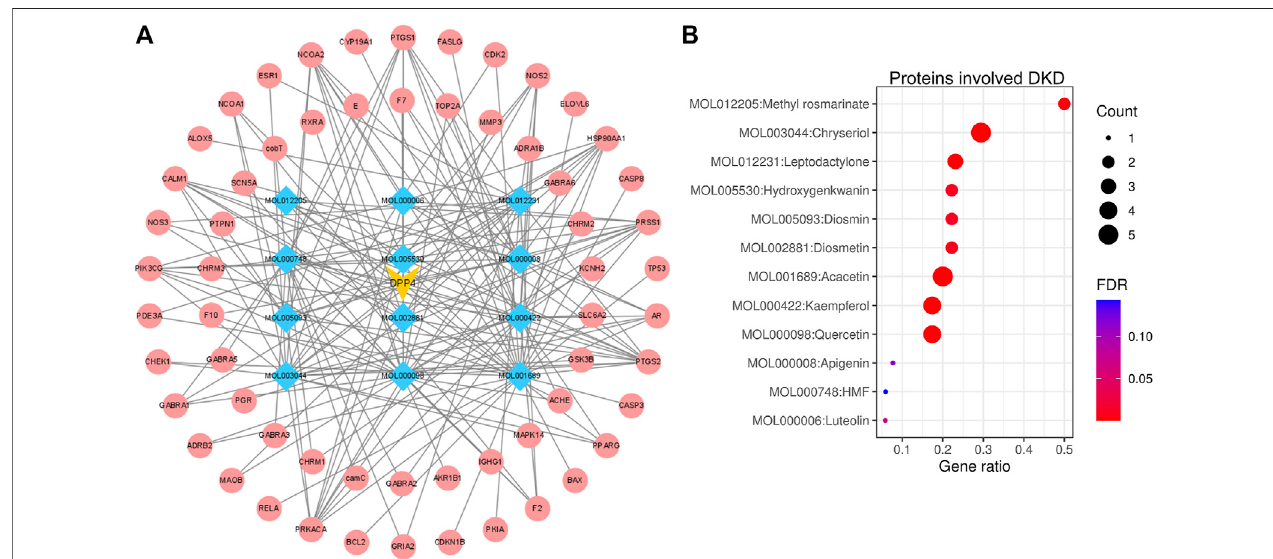
FIGURE 3 | Network construction and signal pathway analysis of DPP4 targeted compounds. (A) DPP4 (yellow)-compound (blue)-target genes (red) network. (B) The enrichment of 12 compound target genes in DKD-related signalling pathways analysed via the ENRICHR website (https://maayanlab.cloud/Enrichr/). Methyl rosmarinate, leptodactylone, acacetin, diosmetin, chryseriol, kaempferol, diosmin, hydroxygenkwanin and quercetin wassigni fi cantly enriched in DKD-related signalling pathways (FDR < 0.05). HMF, apigenin and luteolin was not signi fi cantly enriched in DKD-related signalling pathways (FDR ≥ 0.05). p -value was calculated by Fisher ’ s exact test or the hypergeometric test. The FDR is an adjusted p -value using the Benjamini-Hochberg method for correction for multiple hypotheses testing.